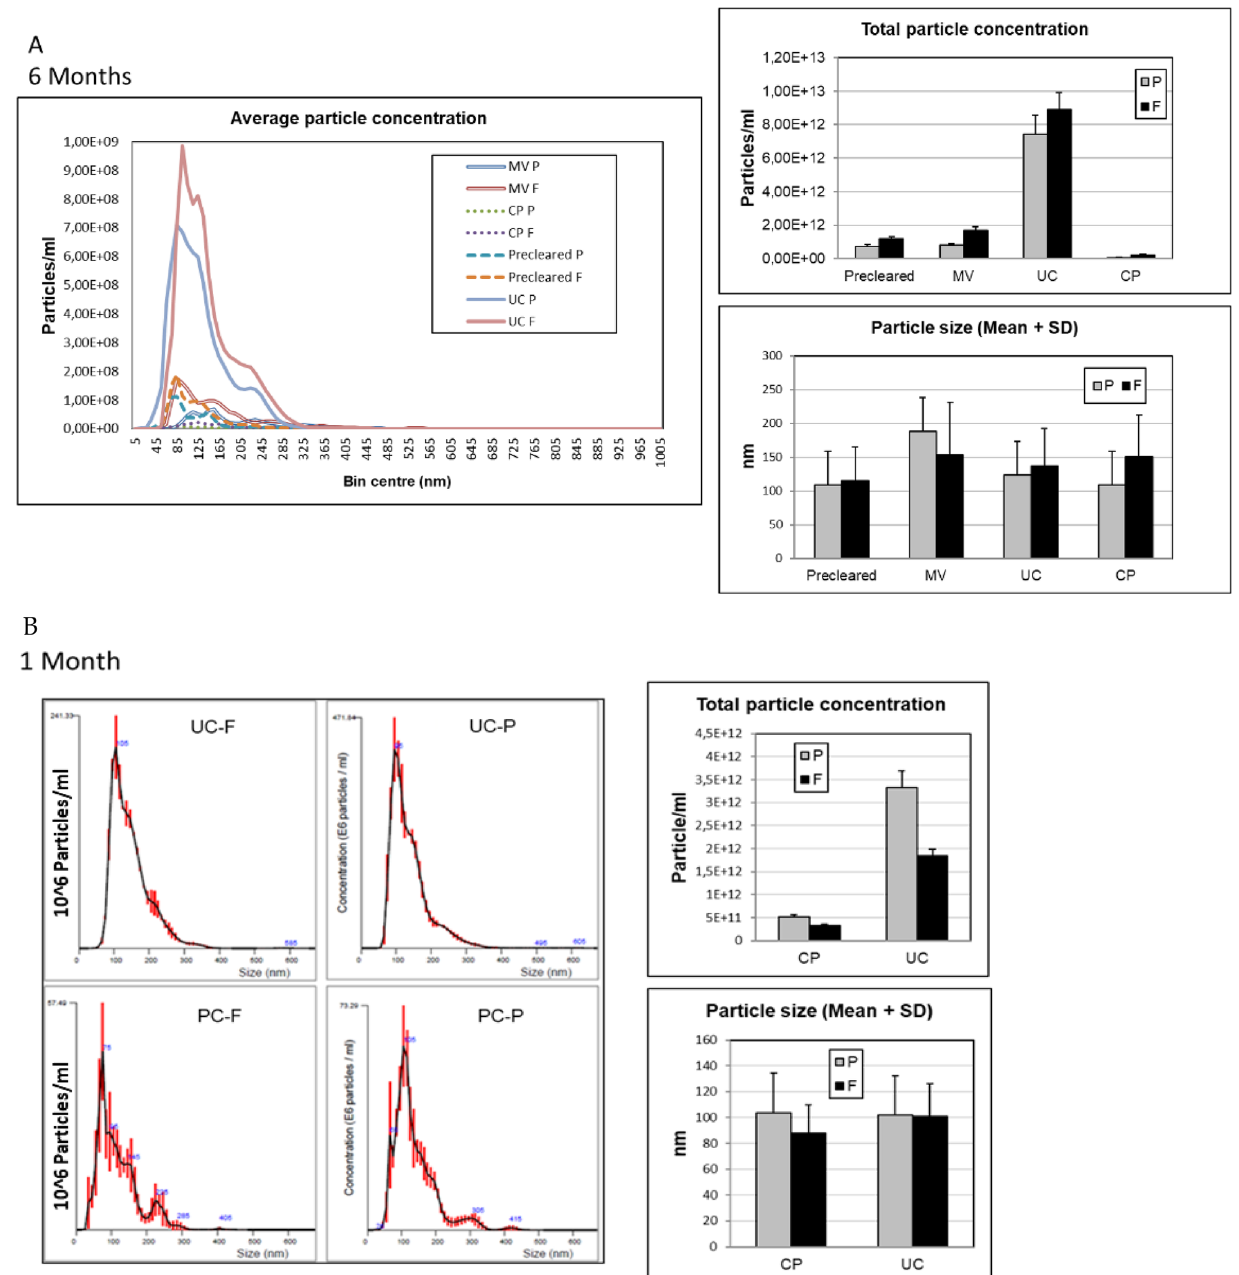
Figure 1. Counting and sizing of extracellular vesicles (EVs) isolated from urine preserved in different conditions. EVs were purified from urine obtained from three healthy volunteers by differential ultracentrifugation (UC) and chemical precipitation (CP) and was either preserved at − 80 °C (F) or adjuvated with the preservant at room temperature (P). Microvesicles (MV) were included in the analysis. Samples from three healthy donors, and 2 independently processed aliquots from each donor, are included in the assessment. Nanoparticle tracking analysis (NTA) analysis shows particle concentration and size as mean + SD after 6 months ( A ) and 1 month ( B ) of storage. The data analysis is done using a non-parametric test for multi-group comparison namely 1-WAY ANOVA followed by Tukey post-hoc test, no significant differences (p-values < 0.05) were